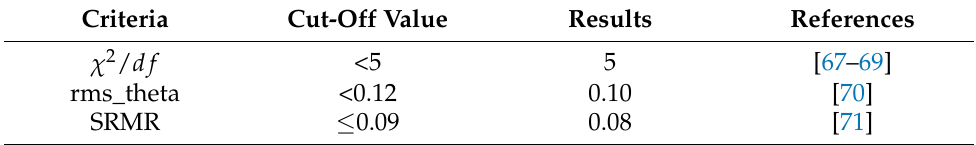
Table 4. The goodness of fit of the structural